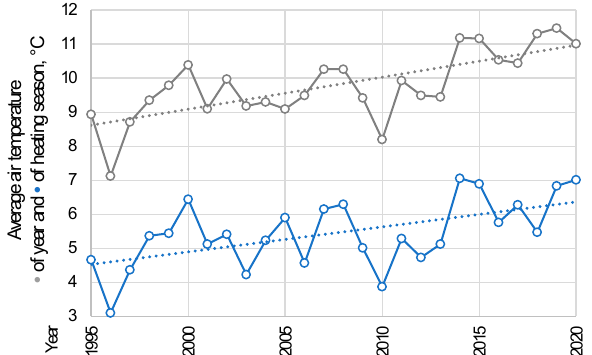
Figure 7. Variability of average air temperature of the year and average air temperature of the heating season in 1995–2019 (own study based on data [23]).